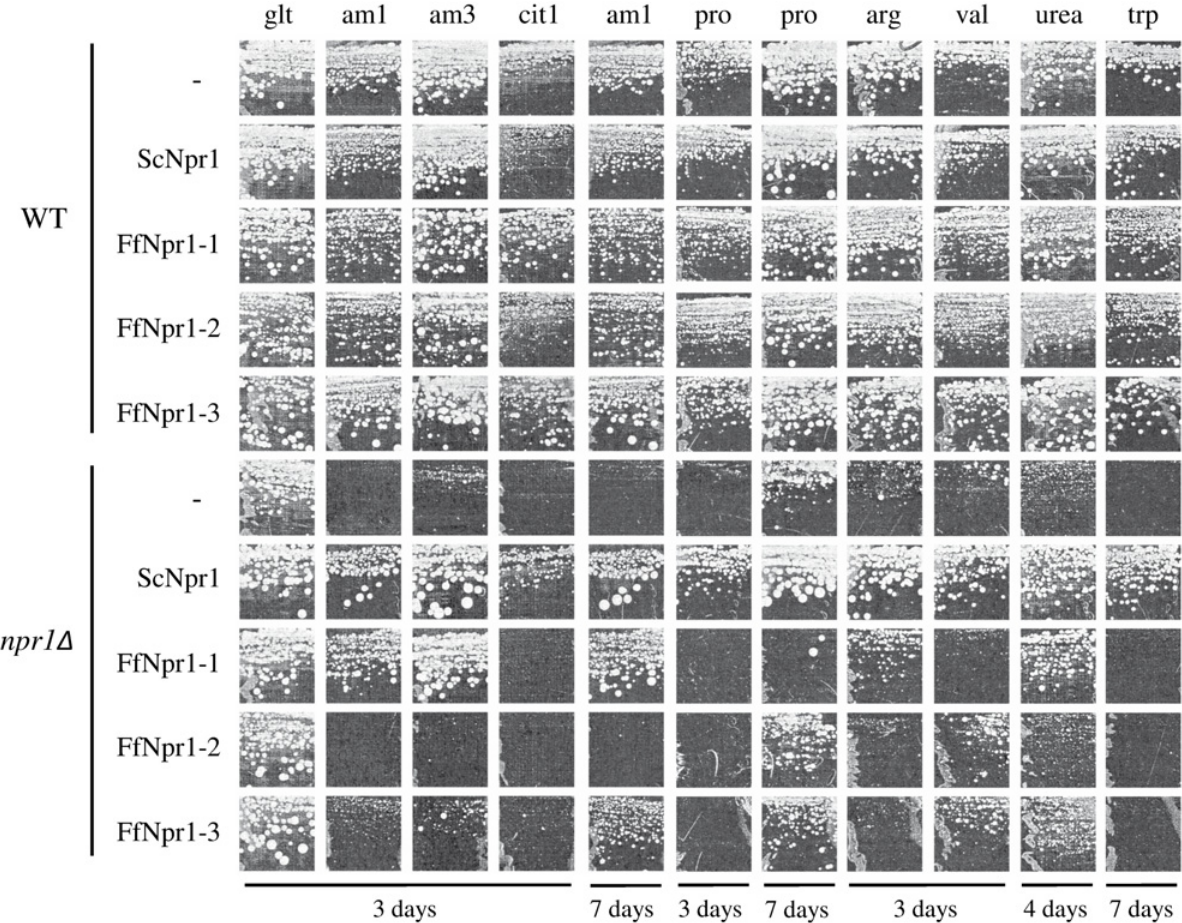
Fig 5. Cross-species complementation of the S . cerevisiae npr1 Δ mutant with F . fujiuroi Npr1-like kinases leads to partial restoration of growth on different nitrogen sources. S . cerevisiae wild-type (WT) and npr1 Δ mutant strains were transformed with FfNPR1-1 , FfNPR1-2 , FfNPR1-3 and ScNPR1 . Fresh cells of tested yeast strains were adjusted to an optical density of 1 and plated on yeast minimal agar with different nitrogen sources: 1 mM